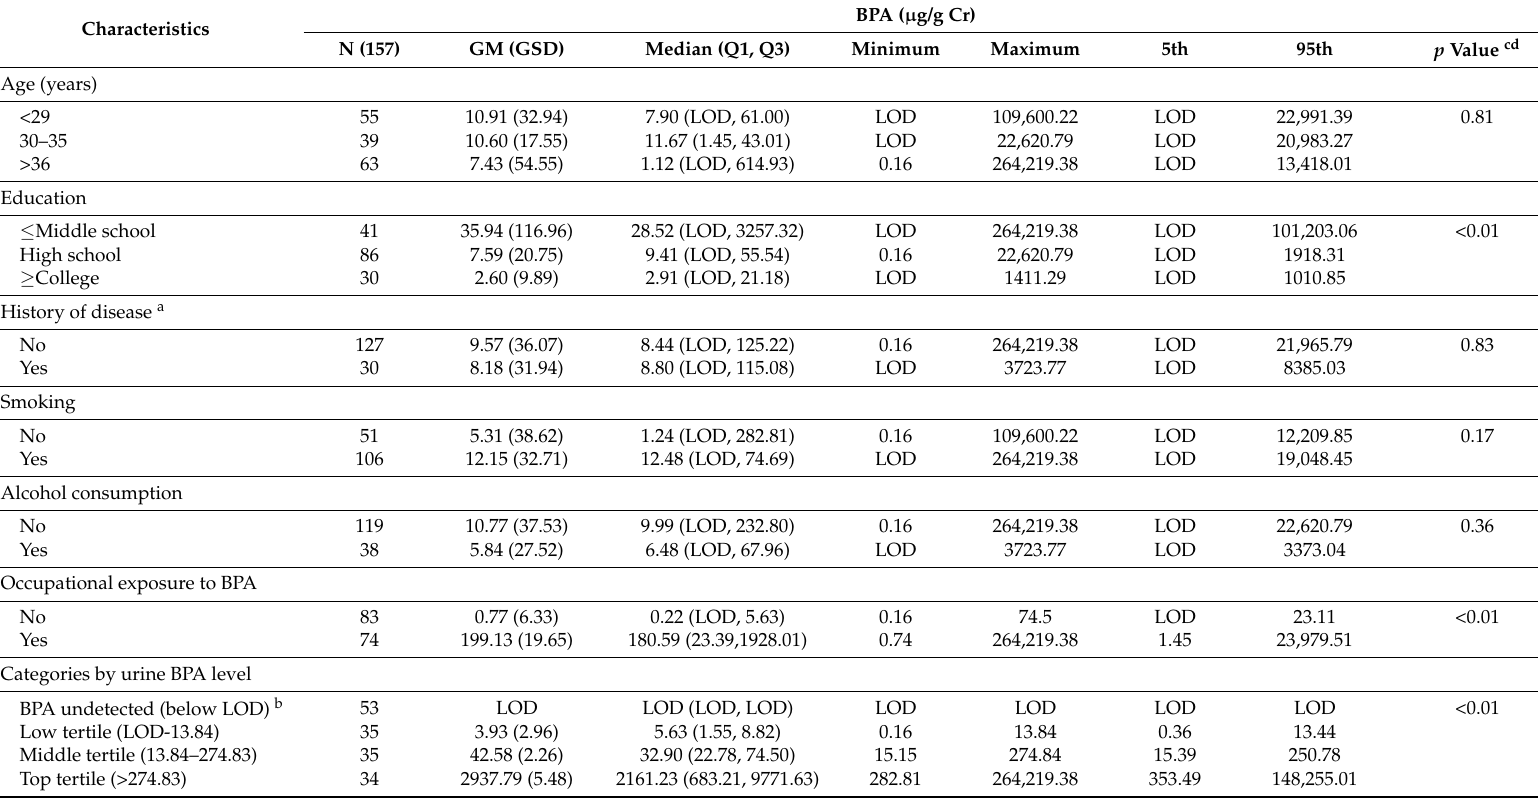
Table 1. Distribution of urine bisphenol A (BPA) by characteristics of the study population ( µ g/g Cr).